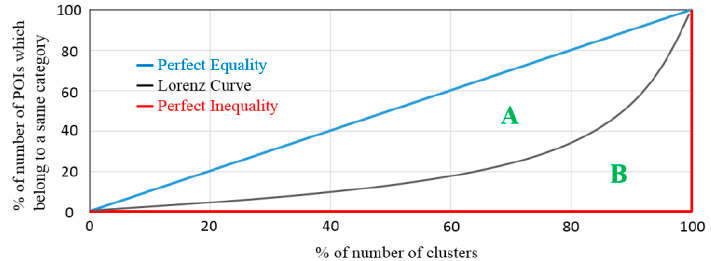
Figure 4. Lorenz Curve.